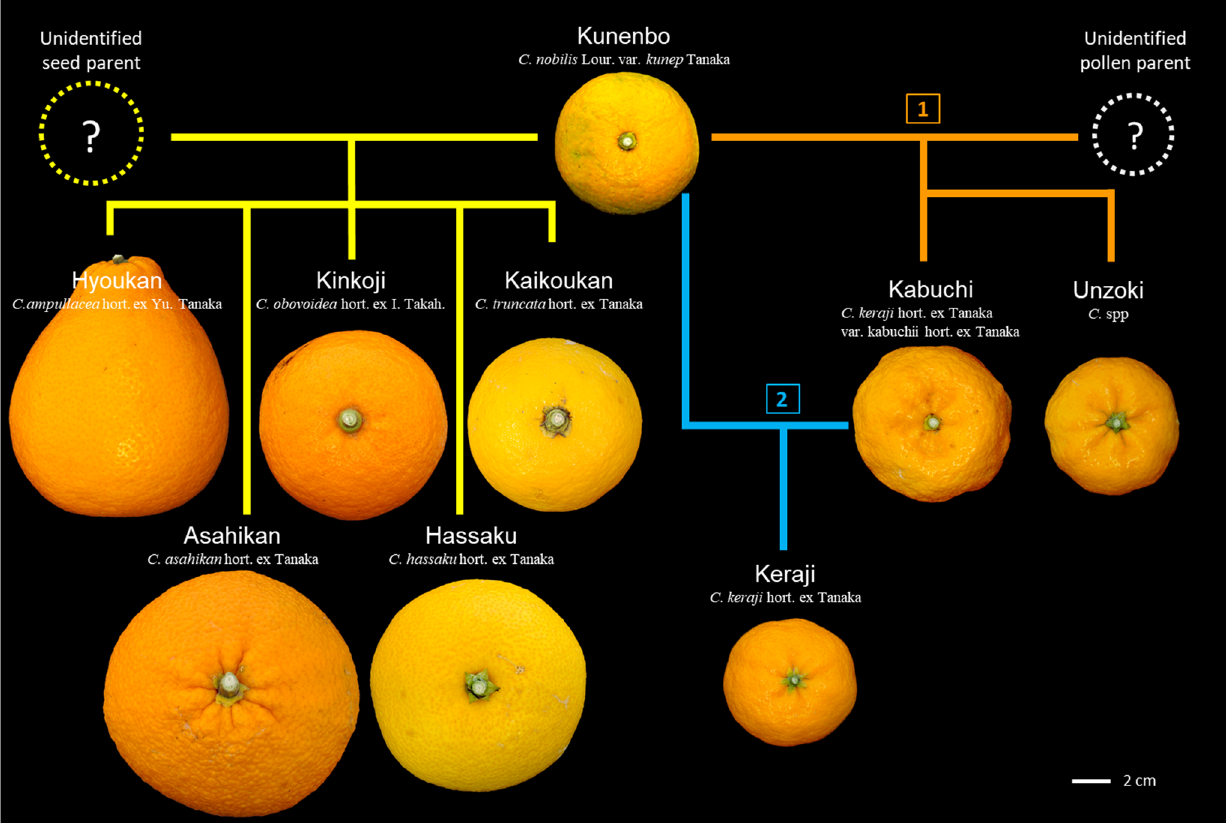
Figure 5. Pedigree of Kunenbo ( C. nobilis Lour. var. kunep Tanaka). The one in the square indicates the first cross of Kishu, and the two in the square indicates the second cross of Kishu. Three cultivars (Kabuchi, Unzoki, and Keraji) that harbor the same cytotype as Kunenbo are small and show thin, orange-colored rind and flesh, and rind puffing typical of a mandarin (Figures 5 and S3). These differences found in fruit traits that correlate with cytotype strongly suggest that the cytotype of the cultivar used as the female parent also affects the fruit traits of the hybrid. Hyoukan is a hybrid from a cross between an unidentified pummelo and Kunenbo; however, the unique ovoid shape of the fruit of Hyoukan is not reminiscent of its parent, Kunenbo. The change in the fruit shape of Hyoukan again indicates that a single cross is enough to result in significant changes in fruit traits, as observed in